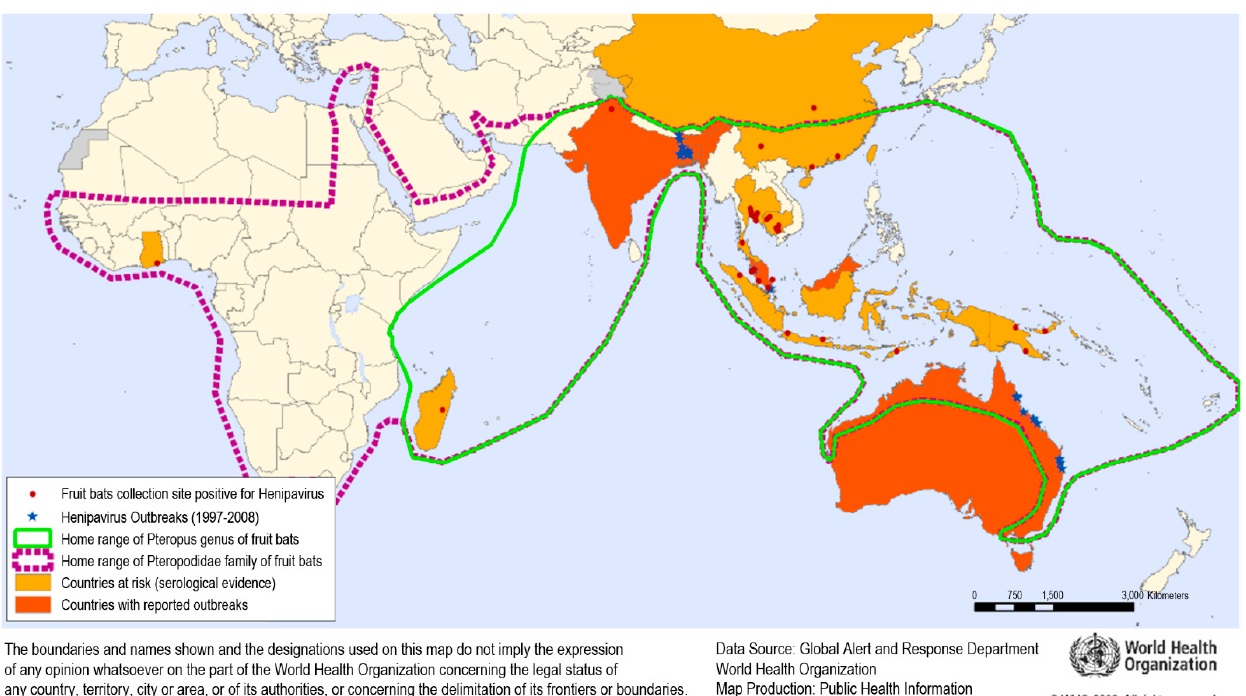
Figure 2. Geographic distribution of Henipavirus outbreaks and fruit bats of the Pteropodidae family. Countries at risk of outbreaks based on collection of positive serological specimens from fruit bats (orange) and countries with reported outbreaks (red) are shown. Violet spots indicate collection sites of fruit bats that resulted positive for Henipavirus, while blue stars indicate sites where Henipavirus outbreaks occurred between 1997 and 2008. Areas indicating the home range of the Pteropus genus of fruit bats (delimited by the green solid contour) and the home range of the Pteropodidae family of fruit bats (areas delimited by the violet dotted contour) are shown. Data source: Global Alert and Response Department, World Health Organization, WHO; map production: Public Health Information and Geographic Information Systems (GIS). Reproduced and adapted according to WHO permission ID: 390902 [65].